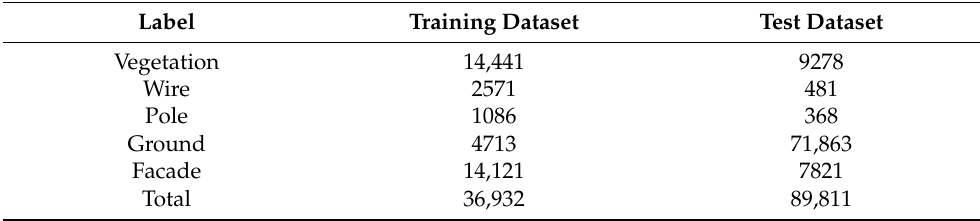
Table 2. Oakland